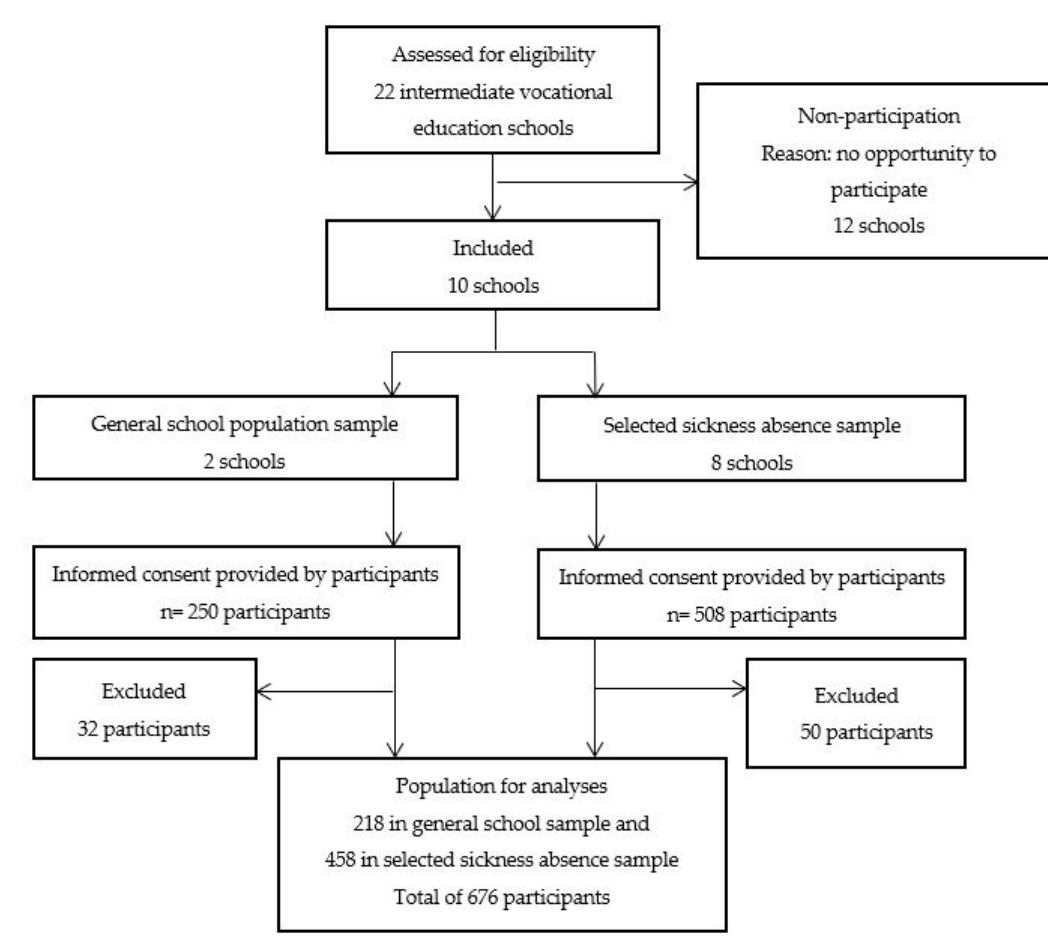
Figure 1. Flowchart of the study population.